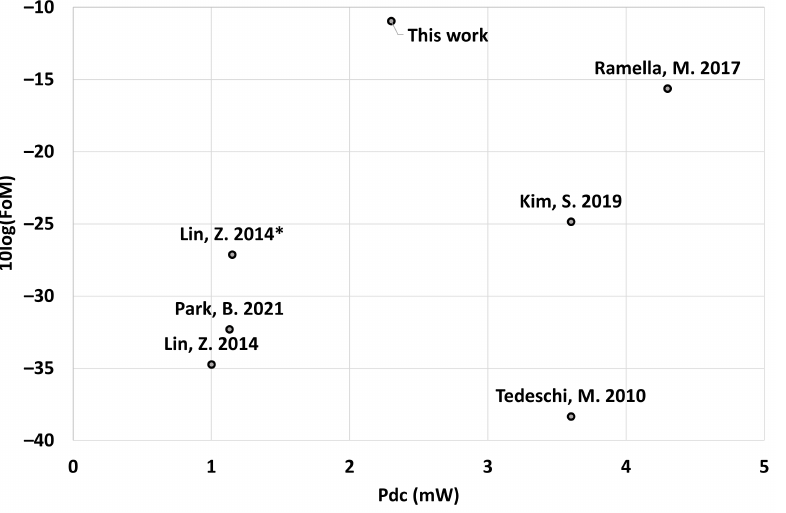
Figure 17. Comparison of the FoM to prior works versus the power consumption. Tedeschi, M.